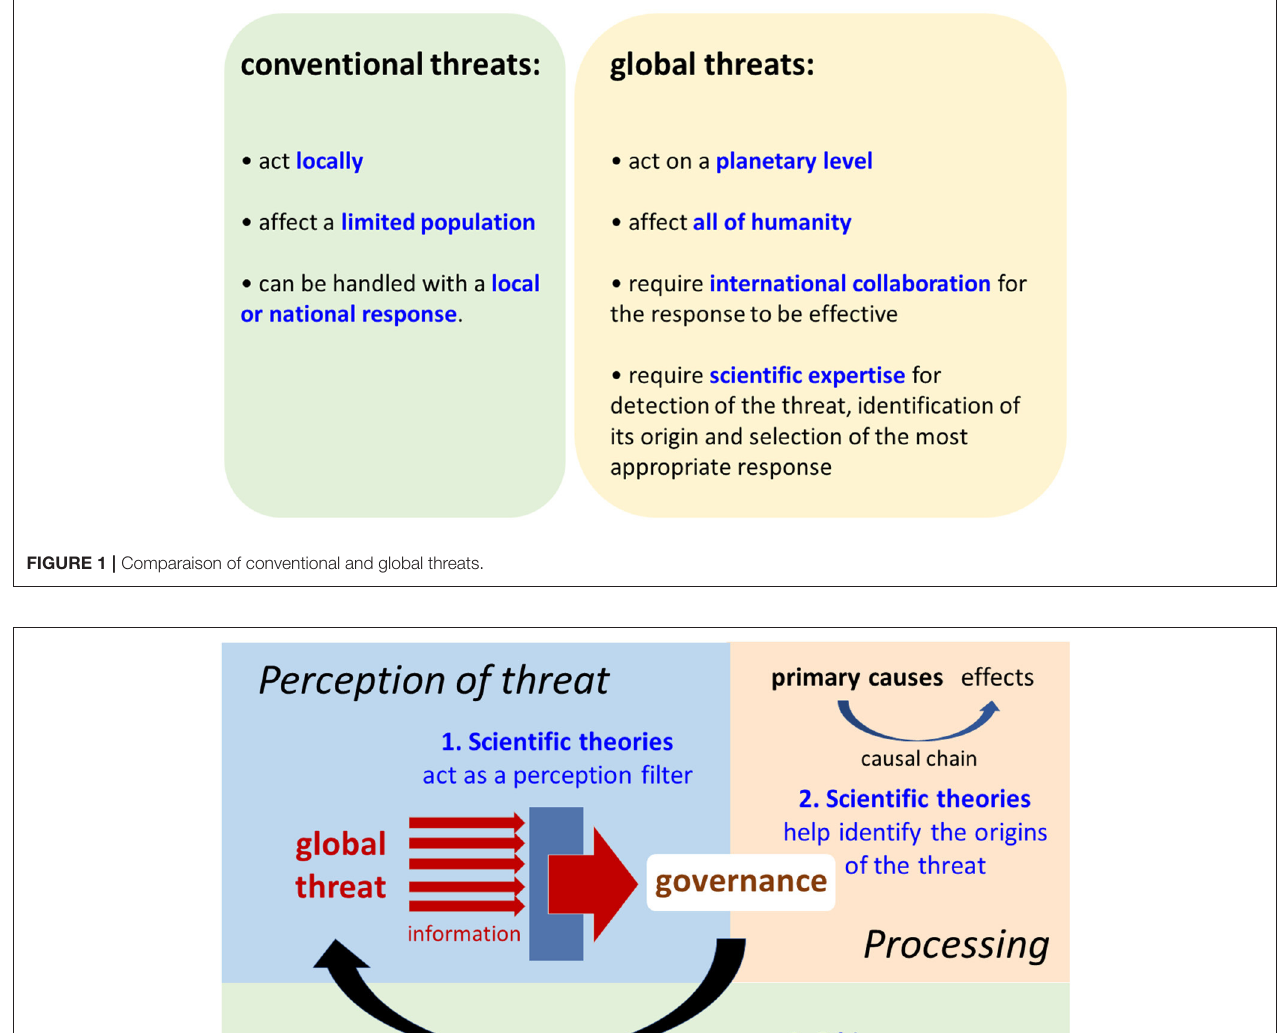
Larmore states that “ In a liberal political order, political principles are to be neutral with respect to controversial views of the good life ” (29). We should note, however, that for Larmore (30) there are “neutral values,” i.e., values like the economy, which are not controversial for a majority of citizens and on which the state can take a position. The state should therefore be neutral only on what is